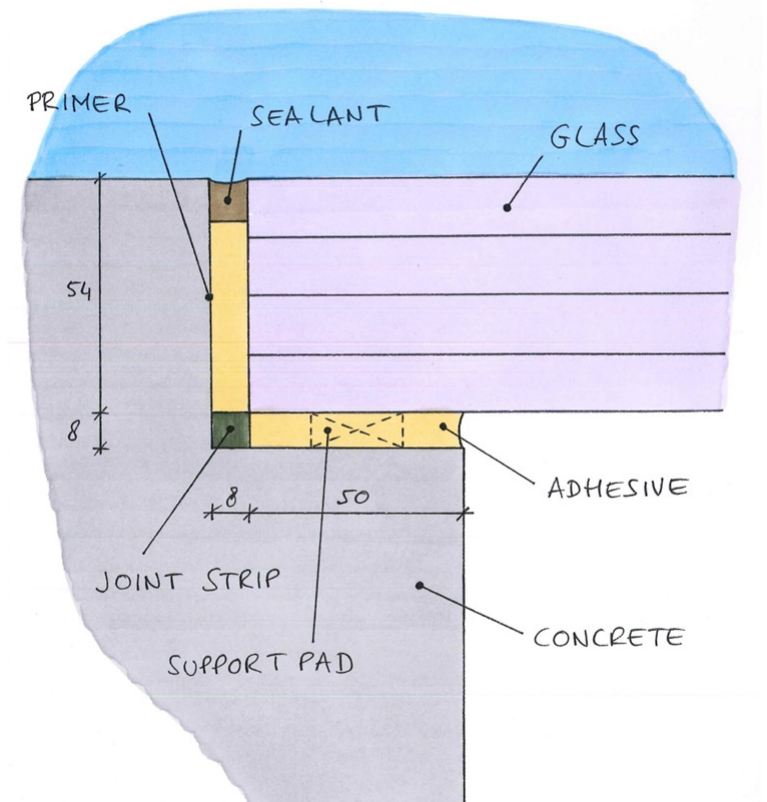
Fig. 4 Support detail (in case of floor